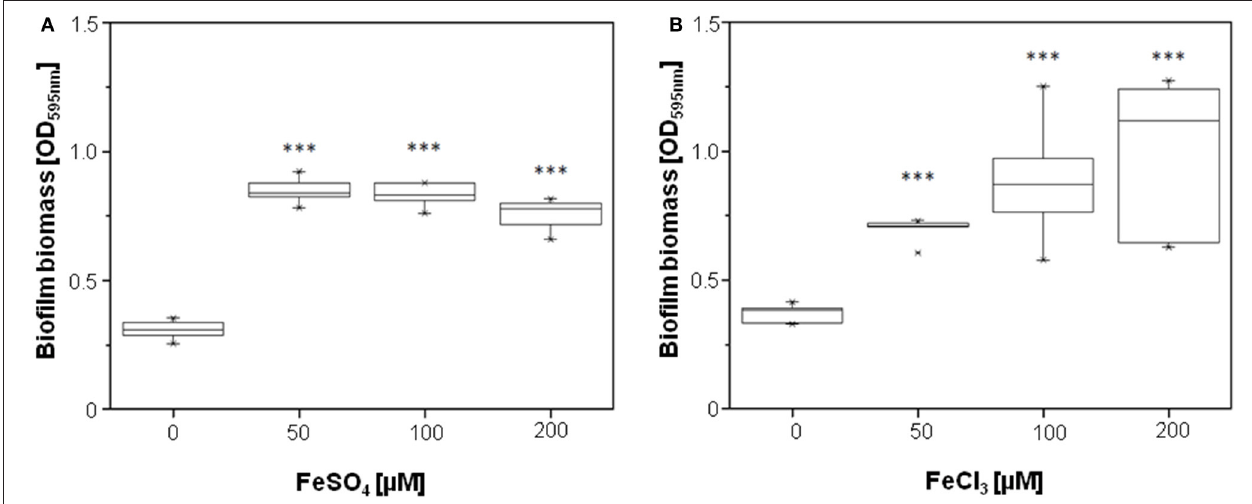
FIGURE 6 | Effect of FeSO 4 and FeCl 3 on biofilm formation of P. aeruginosa PA14 lasB ::Tn. Overnight cultures (in LB) were diluted (10 − 2 ) in BM2 medium, and supplemented with FeSO 4 (A) or FeCl 3 (B) as indicated. After incubation for 24h at 37 ◦ C, cells were stained with 0.1% (w/v) crystal violet and quantified by measuring OD 595nm . Experiments were done in triplicates with 6 individual repeats per measurement ( n = 18). Statistical analyses were performed with the Mann-Whitney U -test. The highest and lowest outliers are indicated by “X.” *** p ≤